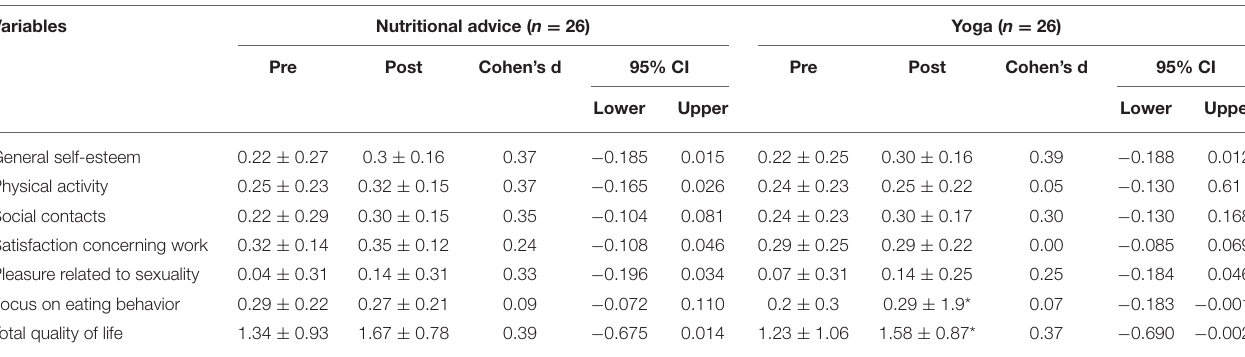
TABLE 7 | Quality of life.